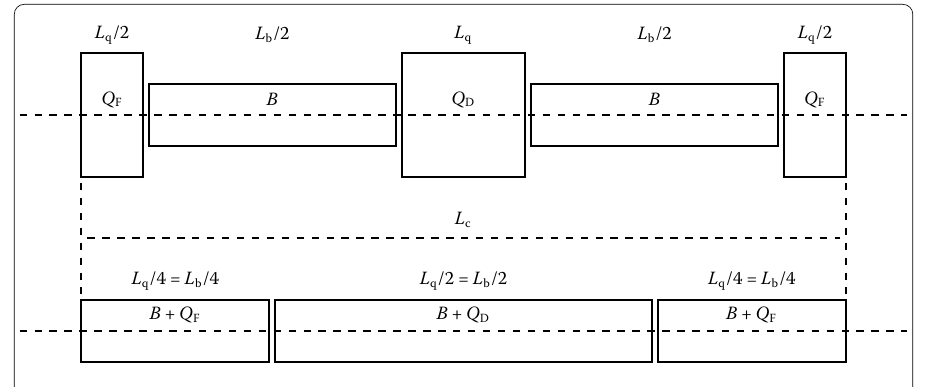
Figure 1 Top: sketch of the layout of a periodic FODO cell. Bottom: sketch of the layout of a periodic CF cell. The type of magnetic field generated by each element is also shown